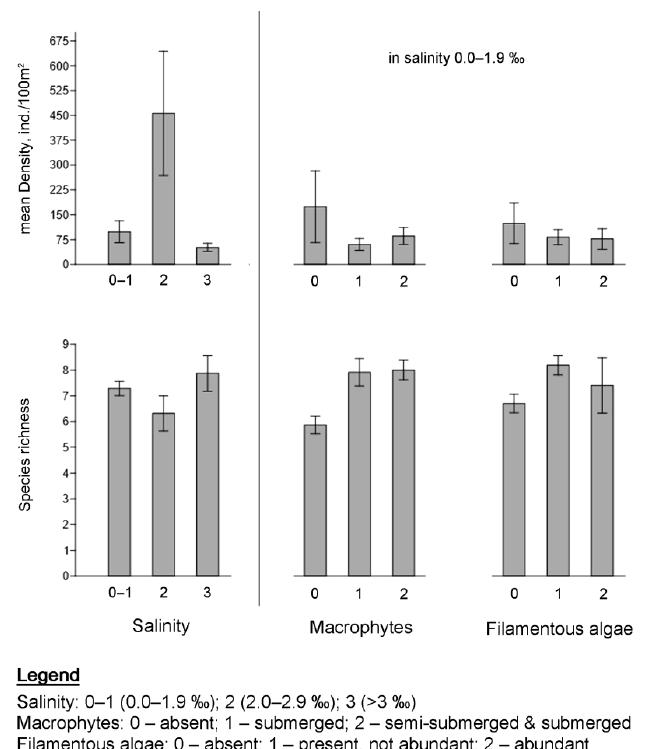
Figure 4. Mean values of fish density per 100 m 2 (above) and species richness (below) for environ- mental factors ‘Salinity ranges’, ‘Macrophytes’, and ‘Filamentous algae’ during summer. Filamentous algae and Macrophytes represent the data with salinity ≤ 1.9‰.